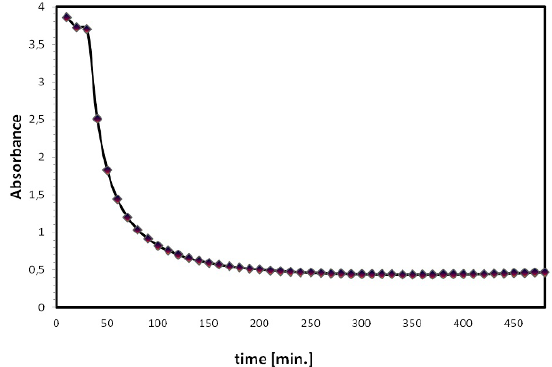
Figure 1. The acrylamide polymerization process controlled by UV absorbance at the wavelength of 260 nm.